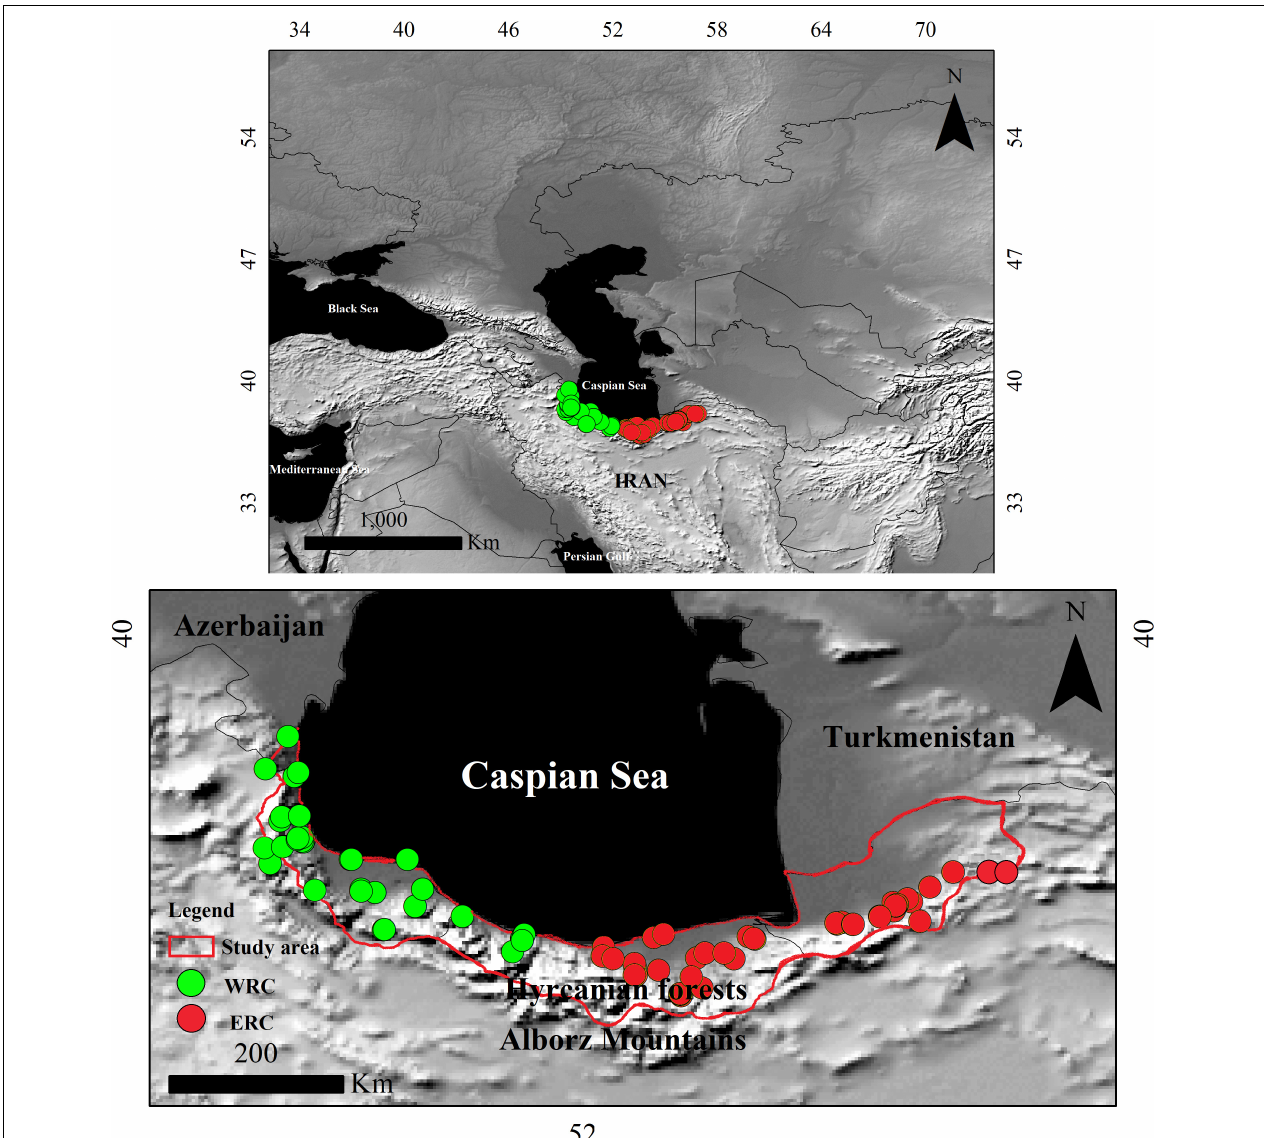
FIGURE 1 | Study area. Hyrcanian forests along the northern slopes of the Alborz mountain range and the southern coastline of the Caspian Sea. The green circles represent the western regional clades (WRC) and the red circles represent the eastern regional clades (ERC) of the Hyrcanian wood frog, Rana pseudodalmatina within its range. A topographic map serves as the